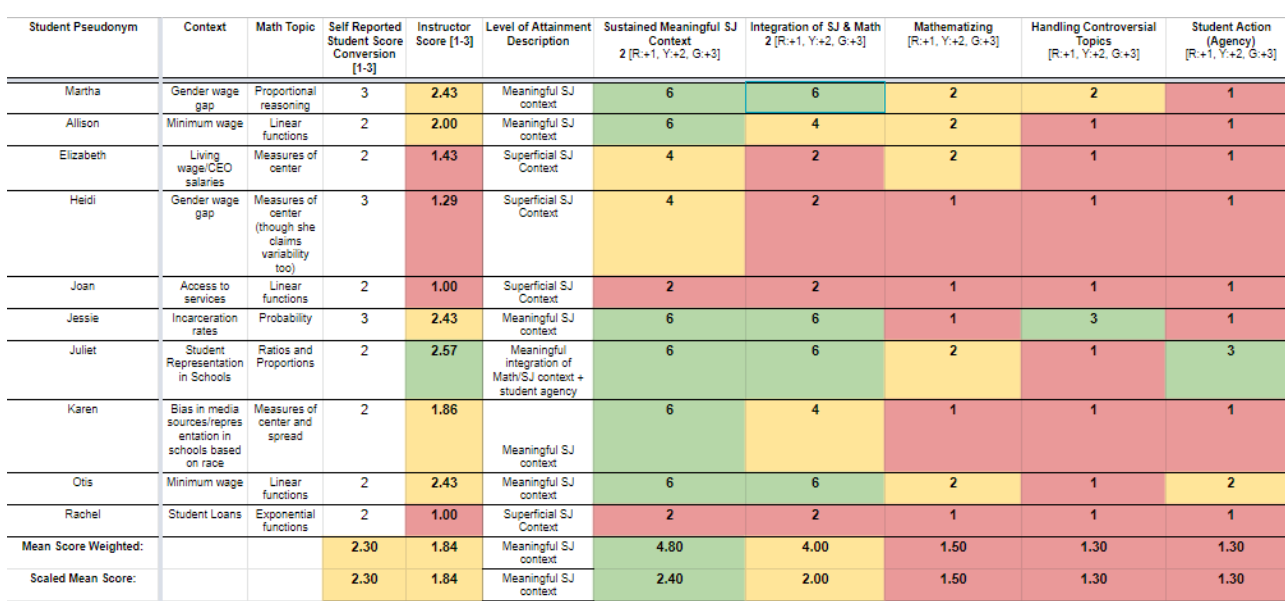
Figure A2. Social justice element analysis for Juliet.